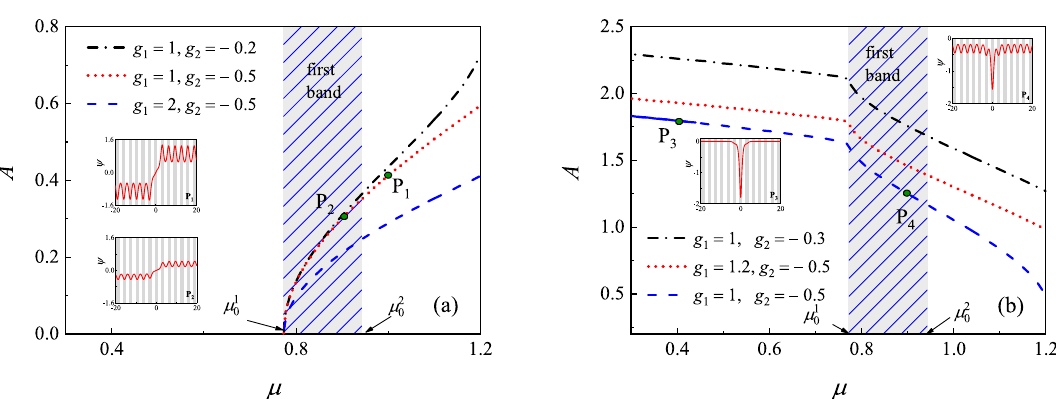
Figure 4. Amplitude of ( a ) kinks and ( b ) bubbles versus the chemical potential µ under different nonlinear interaction strength g 1 and g 2 . The parameters are taken as V 0 0.7726 and µ 2 0.9432 , respectively. µ 1 0 0 ≈ ≈